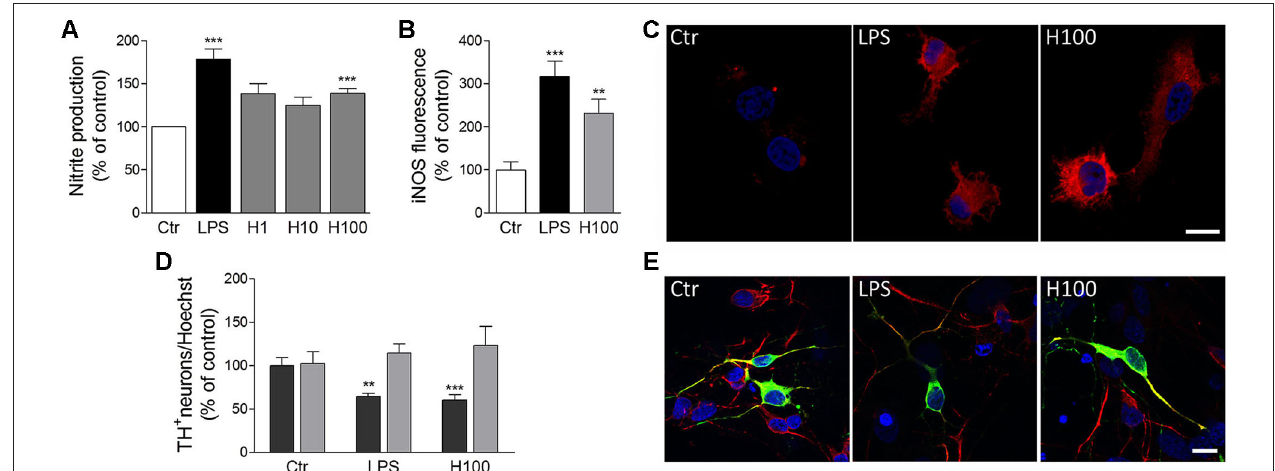
(dark gray bars). The conditioned medium pre-treated solely with histamine or LPS (devoid of microglia-induced soluble factors) did not affect dopaminergic neuronal survival (light gray bars). Results are expressed as the mean value of TH + cells in relation to all nuclei stained with Hoechst. (E) Representative fluorescence digital images of midbrain neuronal-glial co-cultures treated with microglia-derived conditioned medium. Green staining: TH + neurons; red staining: MAP-2 positive neurons; blue staining: nuclei. Scale bar = 10 µ m. Ctr: control; LPS: 100 ng/mL LPS; H100: 100 µ M histamine. Data are expressed as mean ± SEM. Statistical analysis was performed using one-way ANOVA with Dunnett’s correction. ** P < 0.01 and *** P < 0.001 as compared with the untreated control—set to